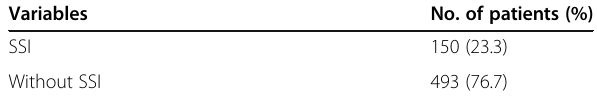
Table 1 Overall rate of SSI